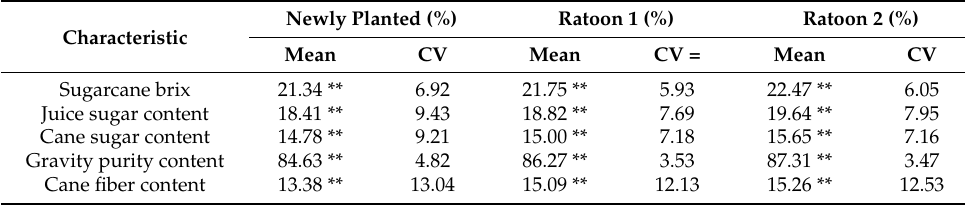
Table 4. Variance analysis of the industrial